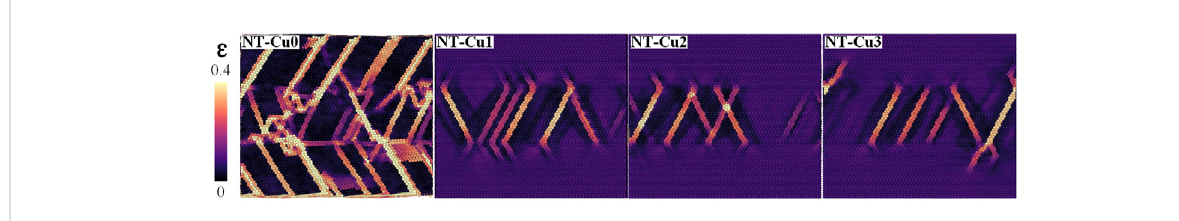
FIGURE 2 Shear strain cloud maps of samples with 10.14% tensile true strain.